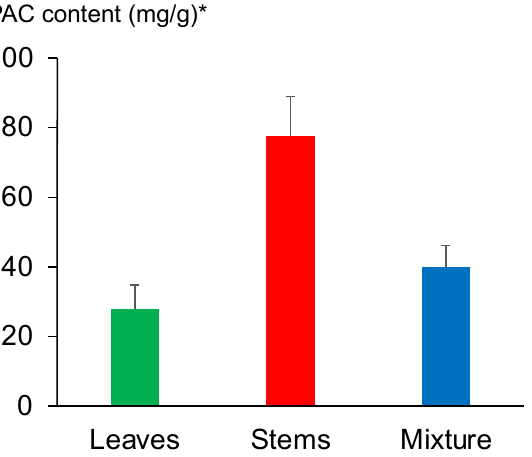
Figure 4. The PAC content of fractions from water extracts of V. virgatum leaves, stems, and leaf/stem mixtures. The data are mean ± SD for 10 individual samples. * The PAC content is substantial quantities of catechin content/dry weight of the extract (mg/g).